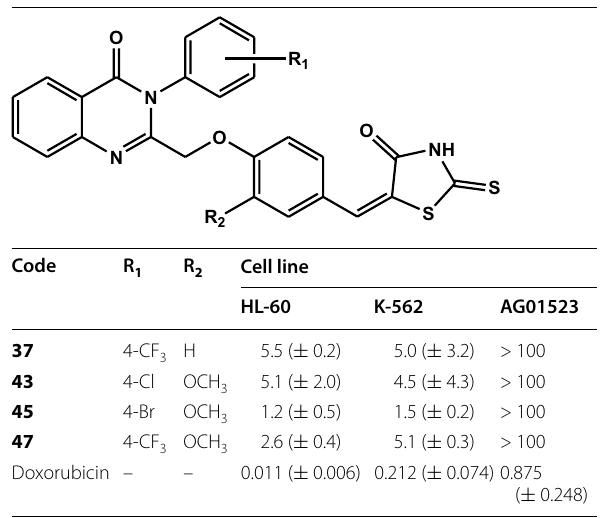
Table 2 Cytotoxicity of selected compounds against a panel of cell strains